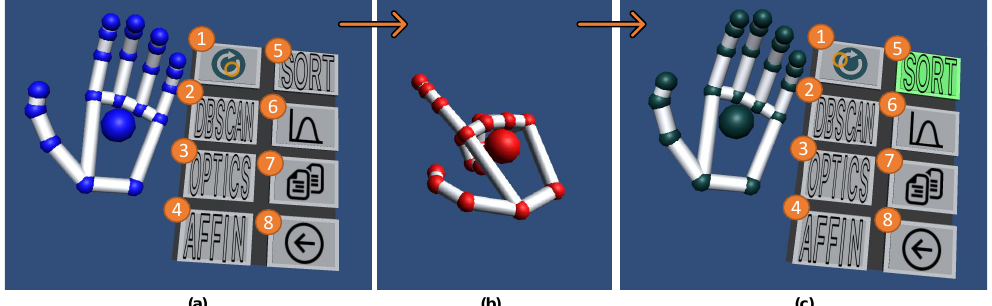
Figure 5. ( a ) The left-hand menu with all the implemented data-science analytics: (1) [ RESTART ] restarts the visualization, (2–4) are the 3D scatter plot clustering solutions attached to individual labeled buttons [ DBSCAN ],[ OPTICS ], and [ AFFIN ], (5) [ SORT ] sorts the axes (i.e., IPCP’s dimen- sions) using their calculated importance, (6) [ TOGGLE ] toggles between the selected and unselected at the moment data items, (7) [ DUPLICATE ] duplicates the selected data items, and (8) [ UNDO ] undoes the most recent manipulation result. ( b ) presents the finger-press gesture used to select a button on the menu. Whereas ( c ) shows the highlighted [ SORT ] after the user pressed that button which cased the importance sorting to be executed on the IPCP as shown in Figure 6. Icons by Icons8 (https://icons8.com, accessed on 23 September